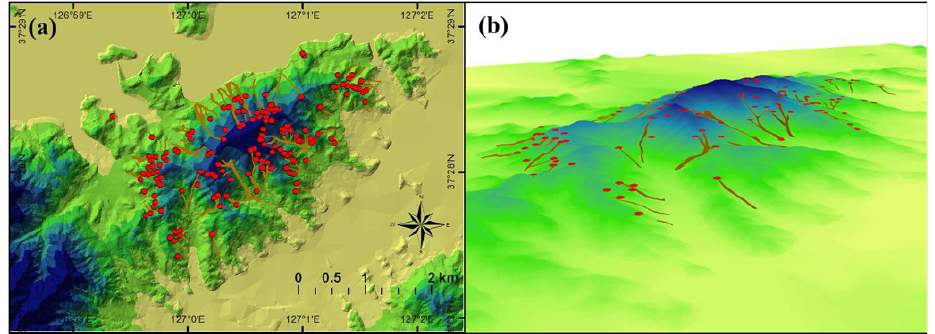
Fig. 4. Landslides and debris flows in the study area: (a) landslide and debris flow mapping and (b) three-dimensional plot of landslide and debris